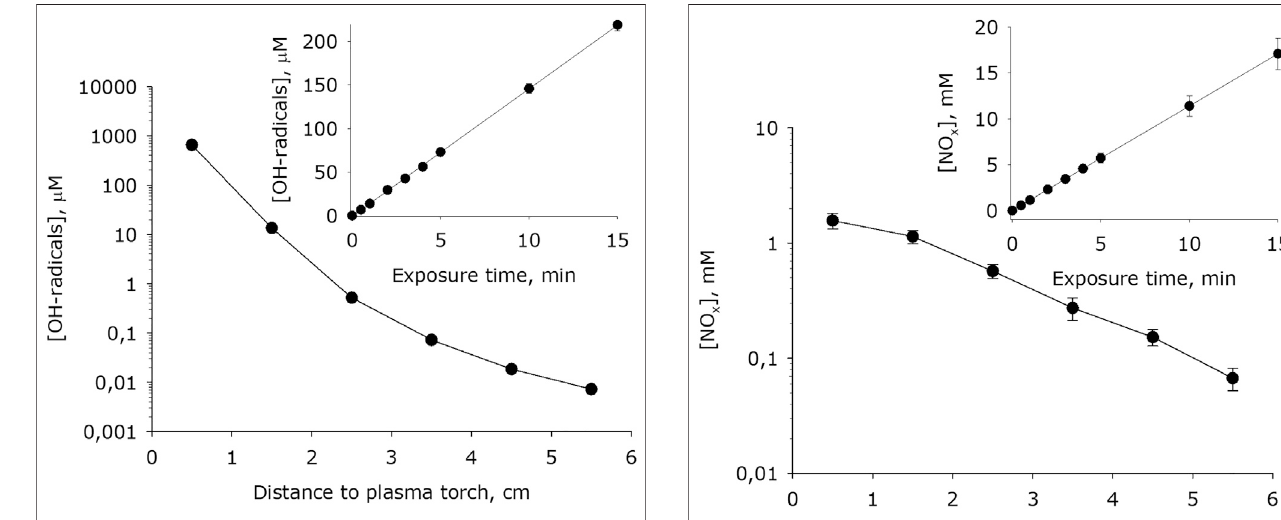
FIGURE 9 | Dependence of hydroxyl radicals concentration formed in water on distance from water surface to the plasma jet nozzle at 1 min of plasma exposure. Data are presented as mean standard error for three independent experiments. Inset shows dependence ofhydroxyl radicals concentration formed in water on the time of plasma exposure at 1.5 cm distance from water surface to the plasma jet nozzle. The data are presented as average values with standard deviation of three experiment repetitions.